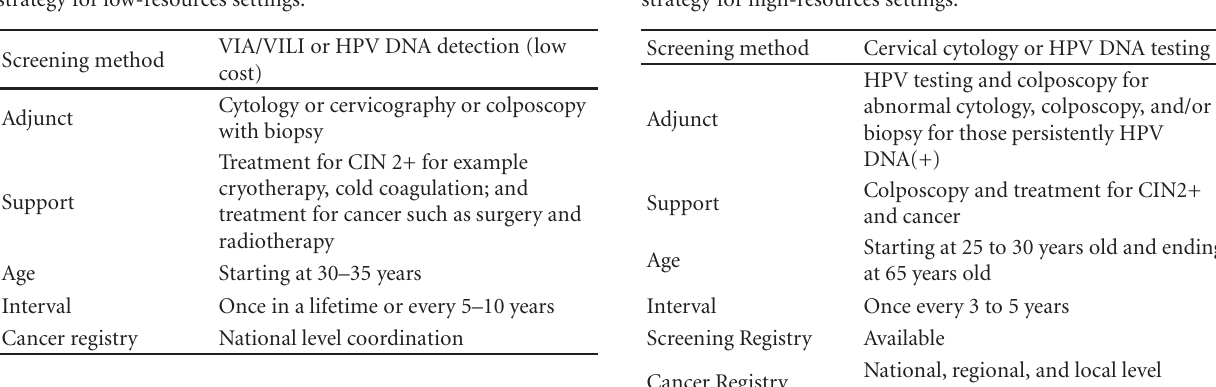
Table 1: Key elements to be considered in choosing a screening strategy for low-resources settings.